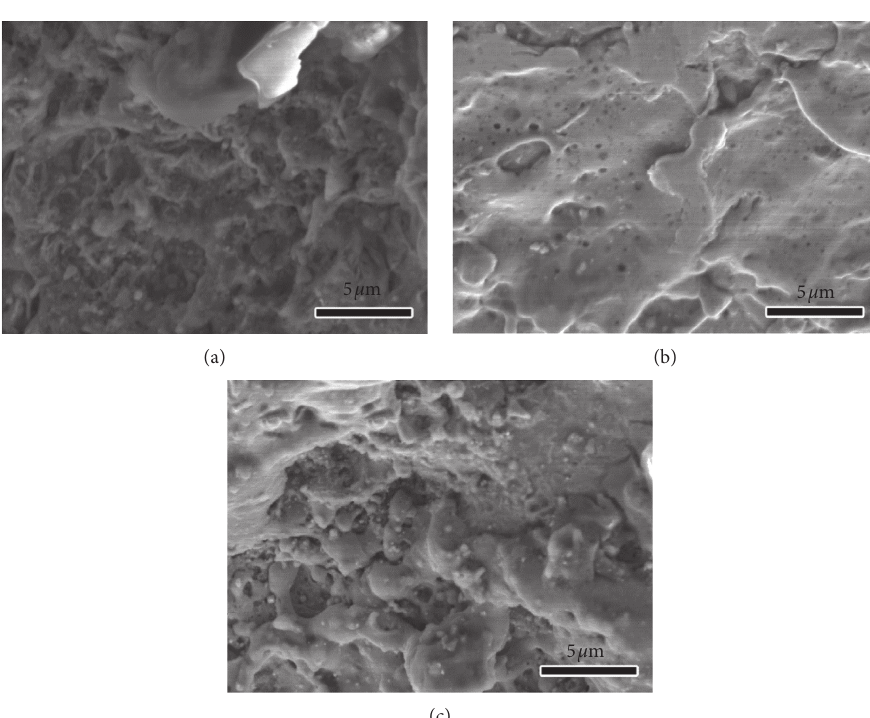
Figure 10: Micrographs of fracture surfaces of the pins of the antishock MOS tube: (a) Pin 1, (b) Pin 2, and (c) Pin